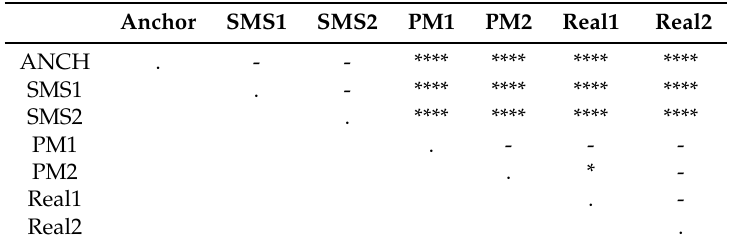
Table 4. The effect of different samples for a broom pole (**** ⇒ p < 0.0001, *** ⇒ p < 0.001, ** ⇒ p < 0.01, * ⇒ p < 0.05, - ⇒ p ≥ 0.05). SMS, spectral modelling synthesis; PM, physical model; Real, recorded